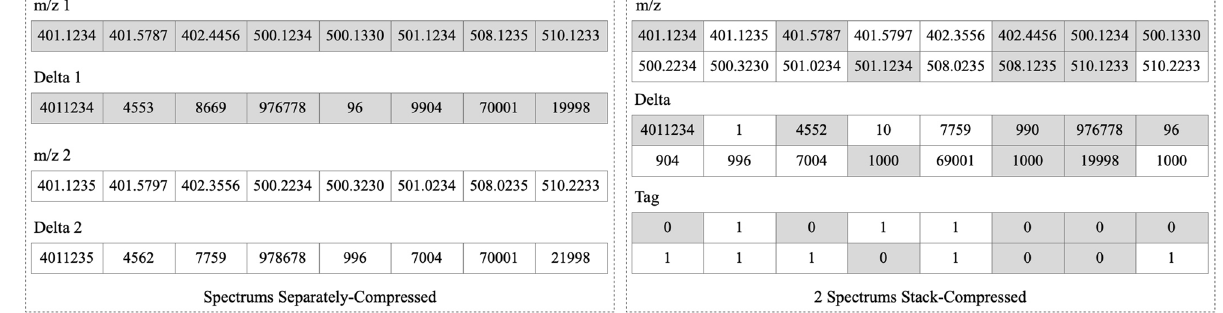
Figure 6. Schematic diagram of Stack-ZDPD compression principle. Floating-point m/z array is converted to ordered integer array, and then replace the later integer with delta of adjacent integers to use pFor library to compress the array. In principle of Stack-ZDPD, we merge several arrays at first and repeat the ZDPD process. Integer from spectrum 1 is in the gray cell, while integer from spectrum 2 is in the white cell. To restore the original arrays, corresponding spectrum tag should be stored. In the given example in the diagram, spectrum 1 is marked as “0”, and spectrum 2, “1”. The computer performs calculation in binary, thus tag of 2 n spectrums require n bits for